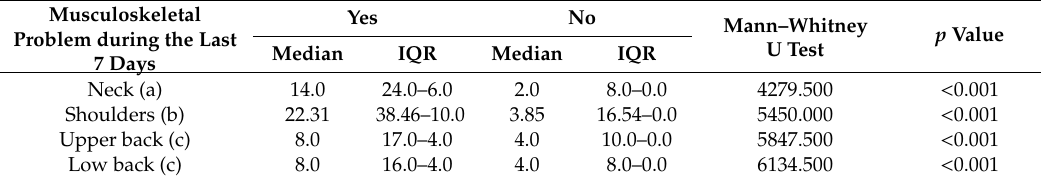
Table 4. Comparison of the disability levels assessed by the relevant questionnaires between the participants with versus without a musculoskeletal problem during the last 7 days ( n =